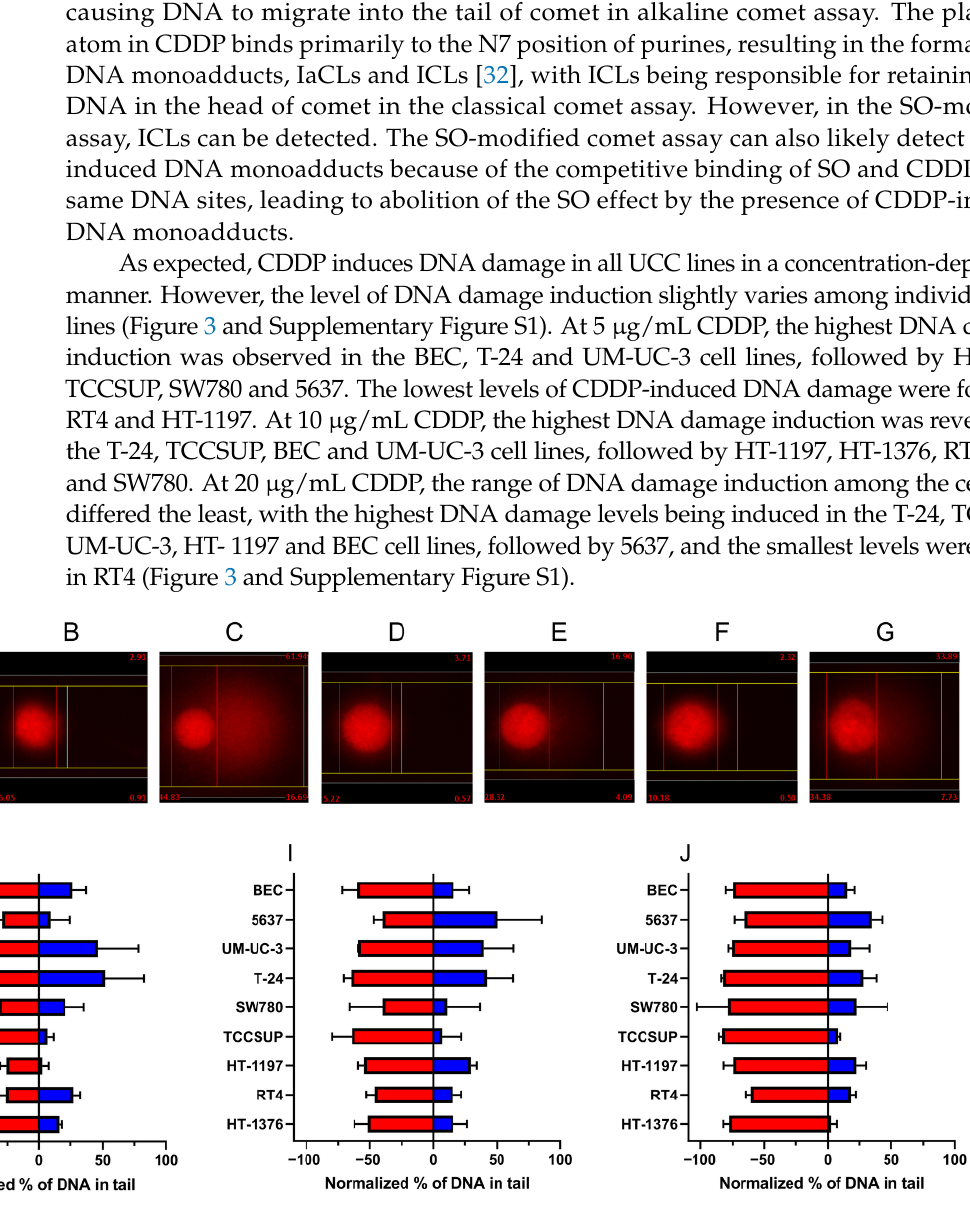
Figure 3. Representative images from the reverse comet assay and comparison of the DNA damage induction and repair in the UCC lines and BEC after CDDP treatment. Representative image for the RT4 cell line is shown. Untreated control (2.26% DNA in tail) ( A ), sample treated with 10 μg/mL CDDP (2.91% DNA in tail) ( B ), sample treated with SO (61.94% DNA in tail) ( C ), sample treated with 10 μg/mL CDDP at 24 h (3.71% DNA in tail) ( D ), sample treated with SO 24 h after 10 μg/mL